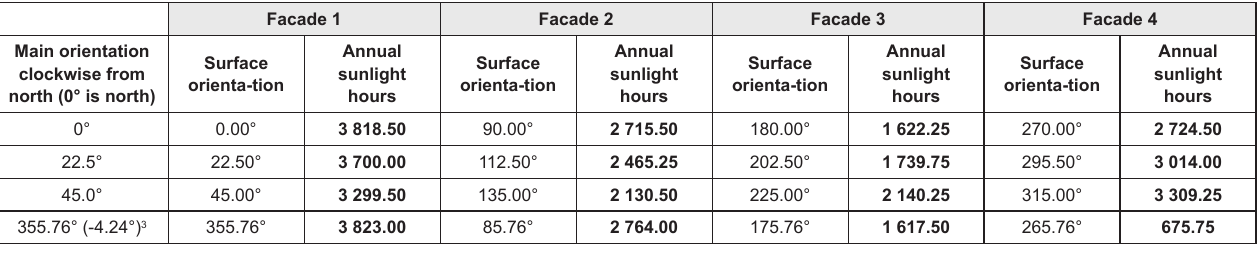
Theoretical maximum amount of sunlight exposure (hours per annum) available for the different facades of a rectangular building with different orientations in the CBD of Pretoria if no overshadowing is taking place Facade 1